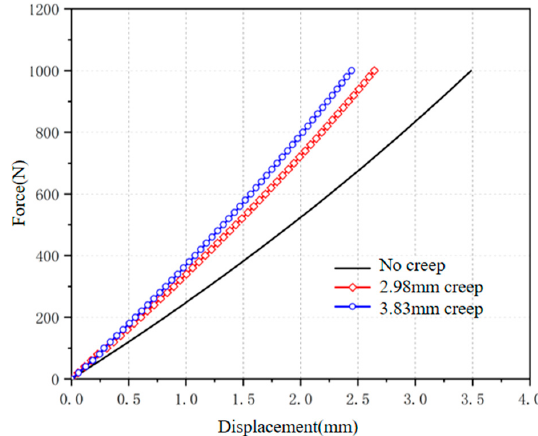
Figure 10. Static stiffness curves of suspension under different creep conditions.